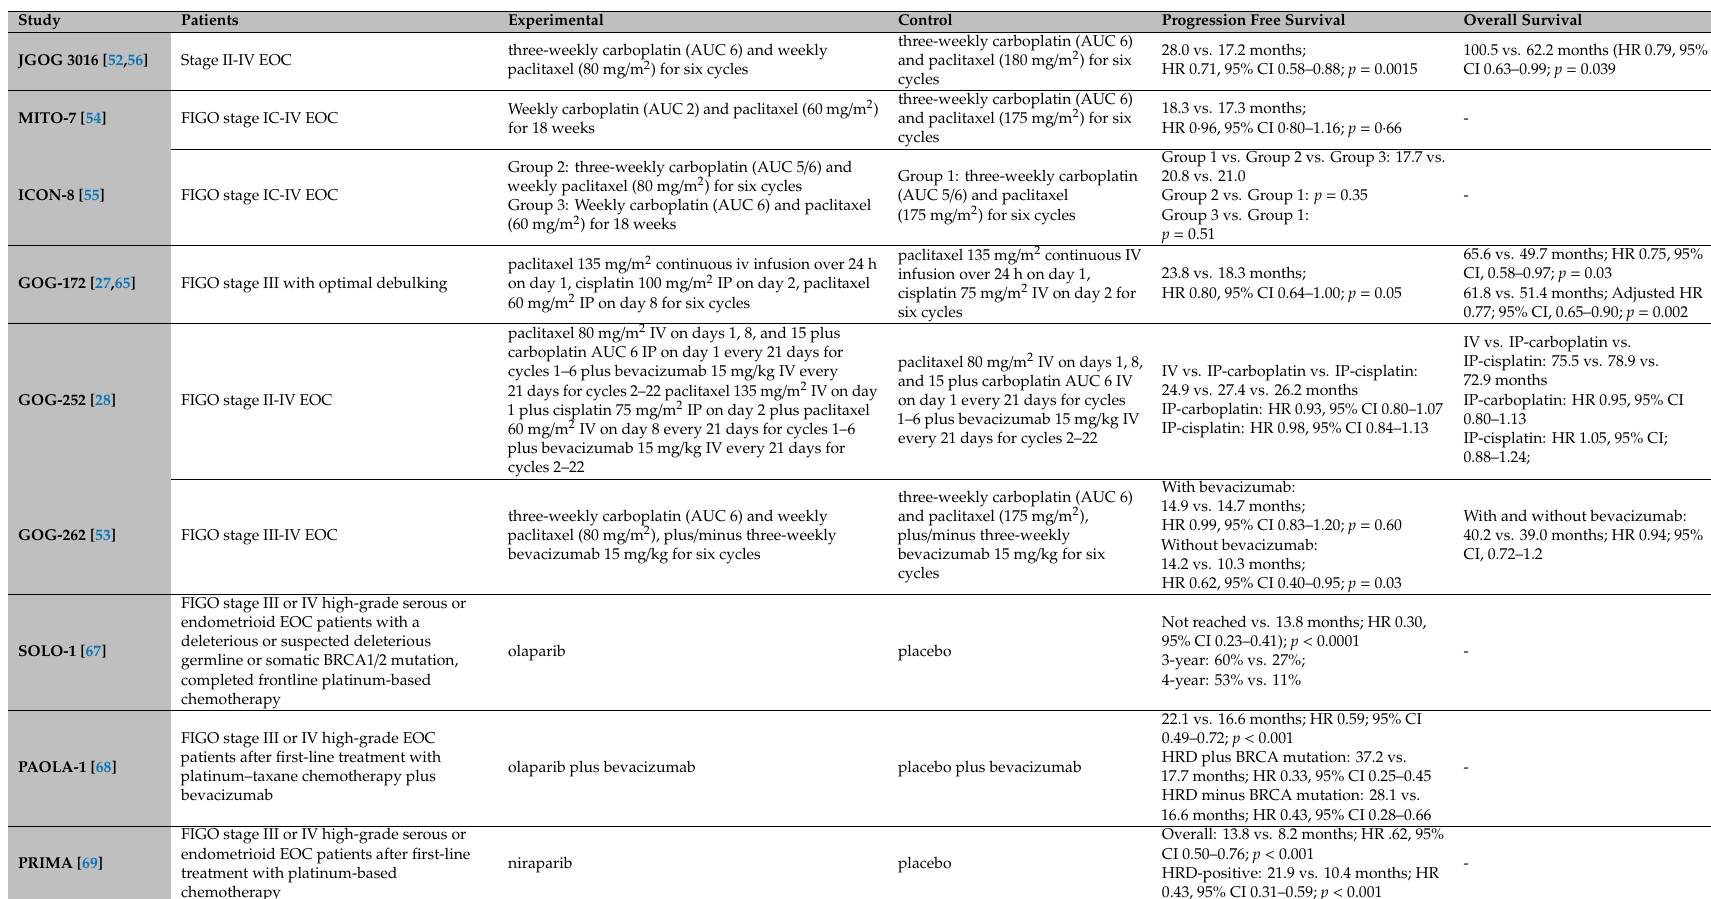
Table 1. Major clinical trials on frontline treatment of epithelial ovarian cancer.